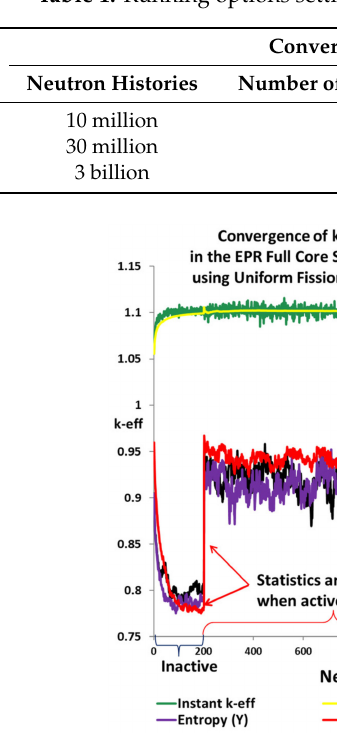
Table 1. Running options setting in Serpent for convergence study.